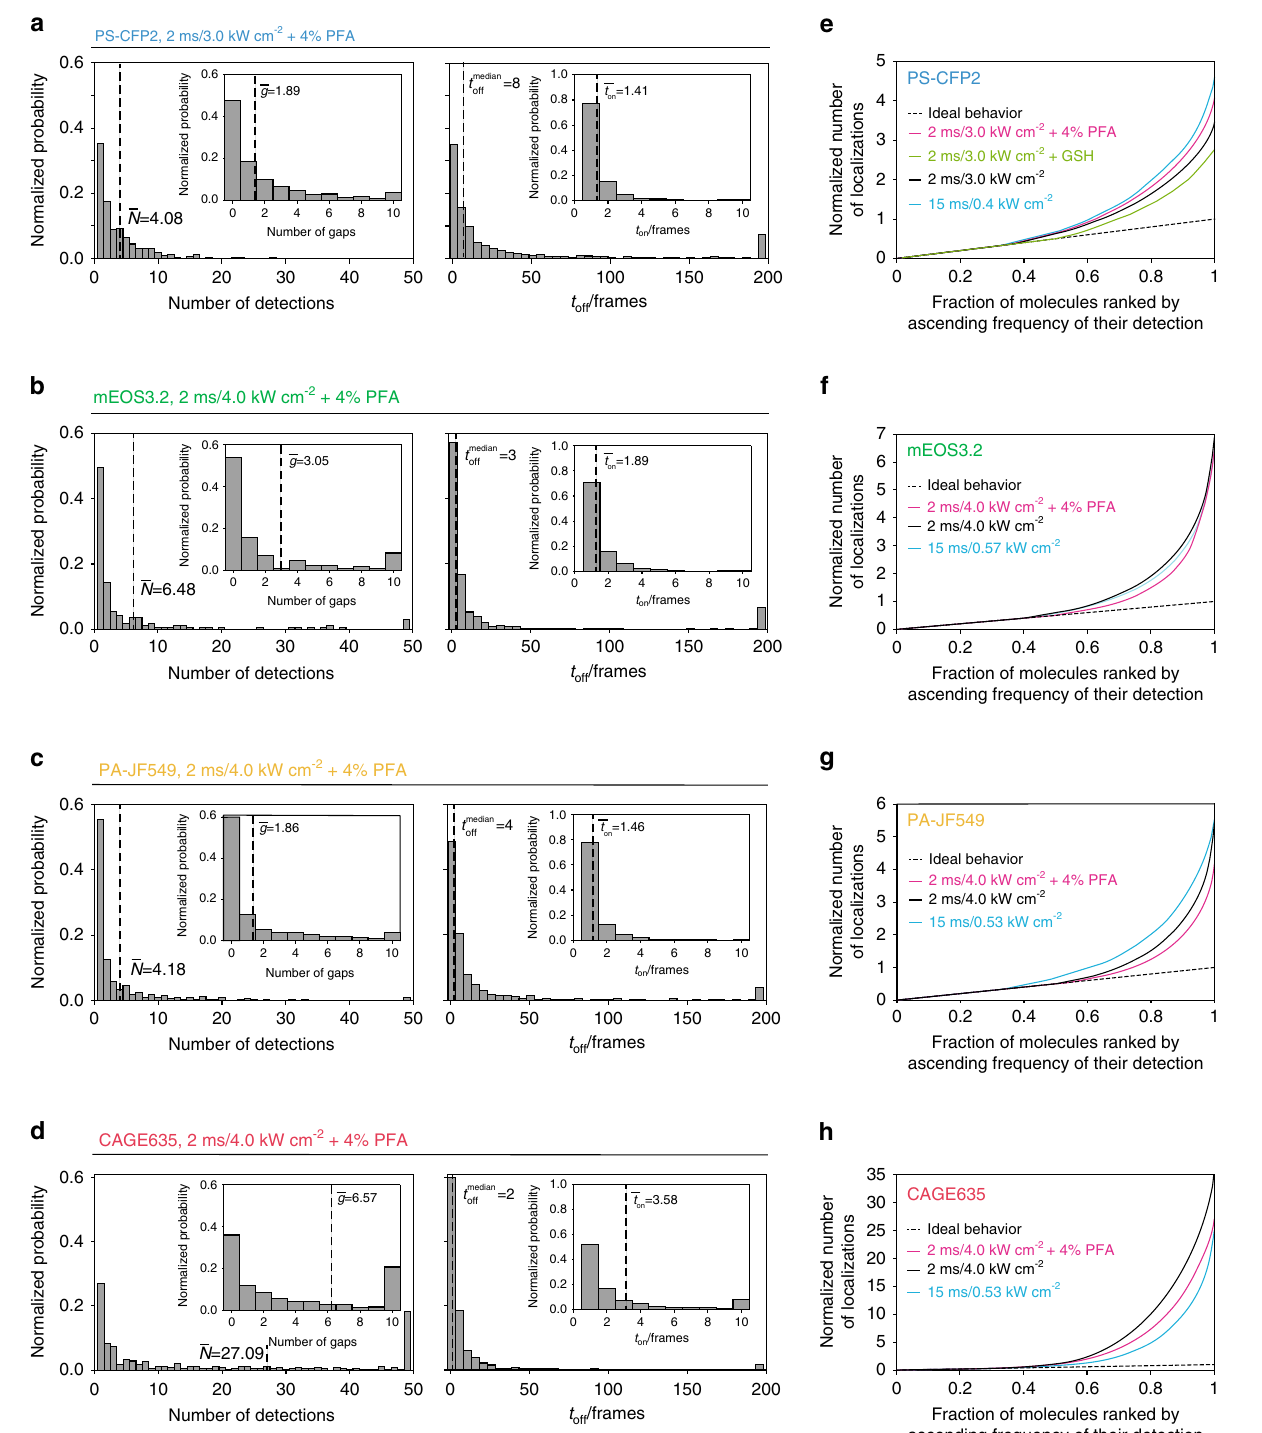
Fig. 2 Quantitation of PS-CFP2, mEOS3.2, PA-JF549, and CAGE635 blinking characteristics treated with 4% PFA and at high power density. a – d Normalized histograms illustrate the four parameters described in (Fig. 1d) determined for two photoswitchable fl uorescent proteins (PS-CFP2 and mEOS3.2) and two photoactivatable organic dyes (PA-JF549 and CAGE635) treated with 4% PFA and at indicated power densities with an illumination time of 2 ms. As indicated, numbers within the histograms indicate the mean or median value of the respective parameter. In total, n = 720 (PS-CFP2), 166 (mEOS3.2), 375 (PA-JF549), and 491 (CAGE635) molecules have been recorded on 77 (PS-CFP2), 56 (mEOS3.2), 72 (PA-JF549), and 156 (CAGE635) independent lipid bilayer positions. e – h Quanti fi cation of PS-CFP2 ( e ), mEOS3.2 ( f ), PA-JF549 ( g ), and CAGE635 ( h ) blinking by plotting the normalized cumulative sum of detections against the fraction of molecules recorded. The black dotted diagonal indicates a hypothetical ideal scenario, in which each PS or PA fl uorescent molecule gives rise to one single detection. Deviations from the diagonal indicate multiple detections per PS or PA fl uorescent molecule. All curves are normalized to the mean number of detections for a given setting. A statistical comparison of the four parameters at indicated imaging conditions and between investigated fl uorophores is provided in Supplementary Tables 1 and